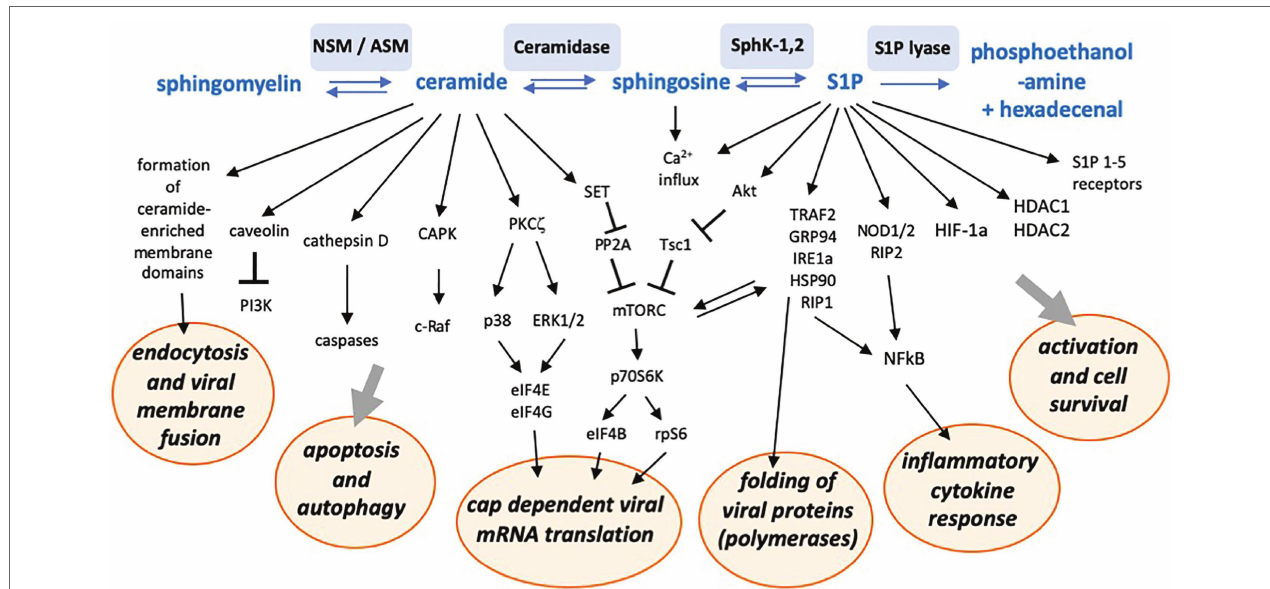
FIGURE 3 | Schematic representation of a number of sphingolipid-associated signaling pathways and interactions with cellular functions potentially supporting or inhibiting viral replication. NSM, neutral sphingomyelinase; ASM, acid sphingomyelinase; SphK-1,2, sphingosine kinases 1 and 2; S1P, sphingosine-1-phosphate; CAPK, ceramide activated protein kinase; PKC, protein kinase C; PP2A, protein phosphatase 2 A; TRAF2, tumor necrosis factor associated factor 2; GRP94, glucose-regulated protein 94; IRE1a, inositol requiring enzyme 1 alpha; Hsp90, heat shock protein 90; RIP1, receptor-interacting protein 1; HDAC, histone deacetylase; and HIF-1a, hypoxia inducing factor 1